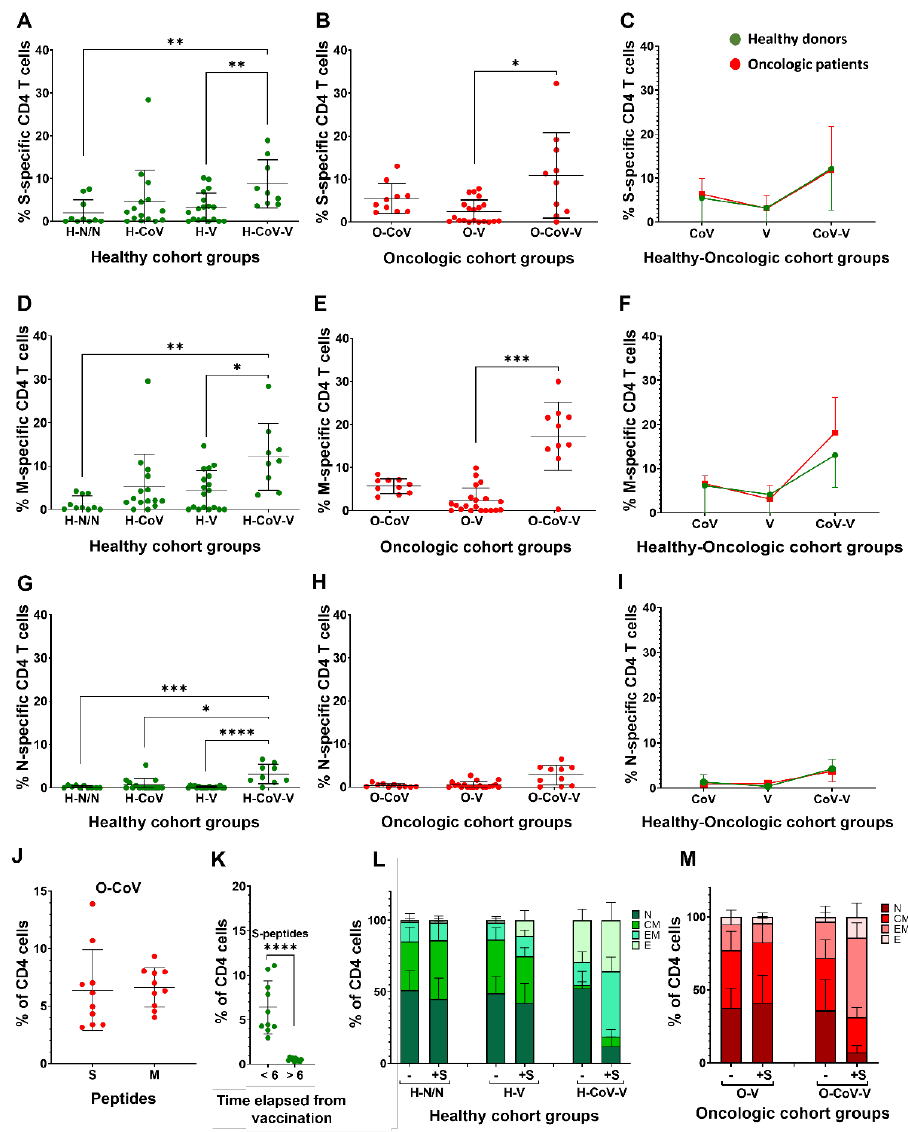
Figure 2. CD4 T-cell responses to S, M and N peptides of SARS-CoV-2 proteins. Paired backgrounds from technical controls were removed from the data. ( A – C ) Percentage CD4 T-cells in PBMCs stim- ulated with S peptides in healthy donors and oncologic patients. ( D – F ) Percentage CD4 T-cells in PBMCs stimulated with M peptides in healthy donors and oncologic patients. ( G – I ). Percentage CD4 T-cells in PBMCs stimulated with N peptides in healthy donors and oncologic patients. ( A , B , D , E , G , H ) Statistical significance was tested by Kruskal–Wallis tests, followed by Dunn’s pair- wise comparison tests. ( J ) Dot plot of the percentage of S and M-specific CD4 T-cells. ( K ) Dot plot of S-specific CD4 T-cells from samples collected at the indicated timelines after completion of vaccination regimes. ( C , F , I , J , K ) Pair-wise comparisons were performed using the Mann–Whitney U-test. ( L , M ) Relative percentages of CD4 T-cell differentiation phenotypes in healthy donors and oncologic patients. Detailed statistical differences are shown in Figure S5. N, CM, EM and E, indi- cate naïve-stem cell (CD62L+ CD45RA+), central memory (CD62L + CD45RA neg ), effector memory (CD62L neg CD45RA neg ) and effector (CD62L neg CD45RA + ) phenotypes. H-N/N—non-vaccinated, non-COVID-19 donors; H-CoV—healthy donors with previous COVID-19 infection; H-V—vaccinated healthy donor; H-CoV-V—vaccinated healthy donor with previous COVID-19; O-CoV—oncologic pa- tient with previous COVID-19; O-V—vaccinated oncologic patients; O-CoV-V—vaccinated oncologic patients with previous COVID-19; *, **, *** and **** indicate significant ( p < 0.05), very significant ( p < 0.01), highly significant ( p < 0.001) and very highly significant ( p < 0.0001) differences,